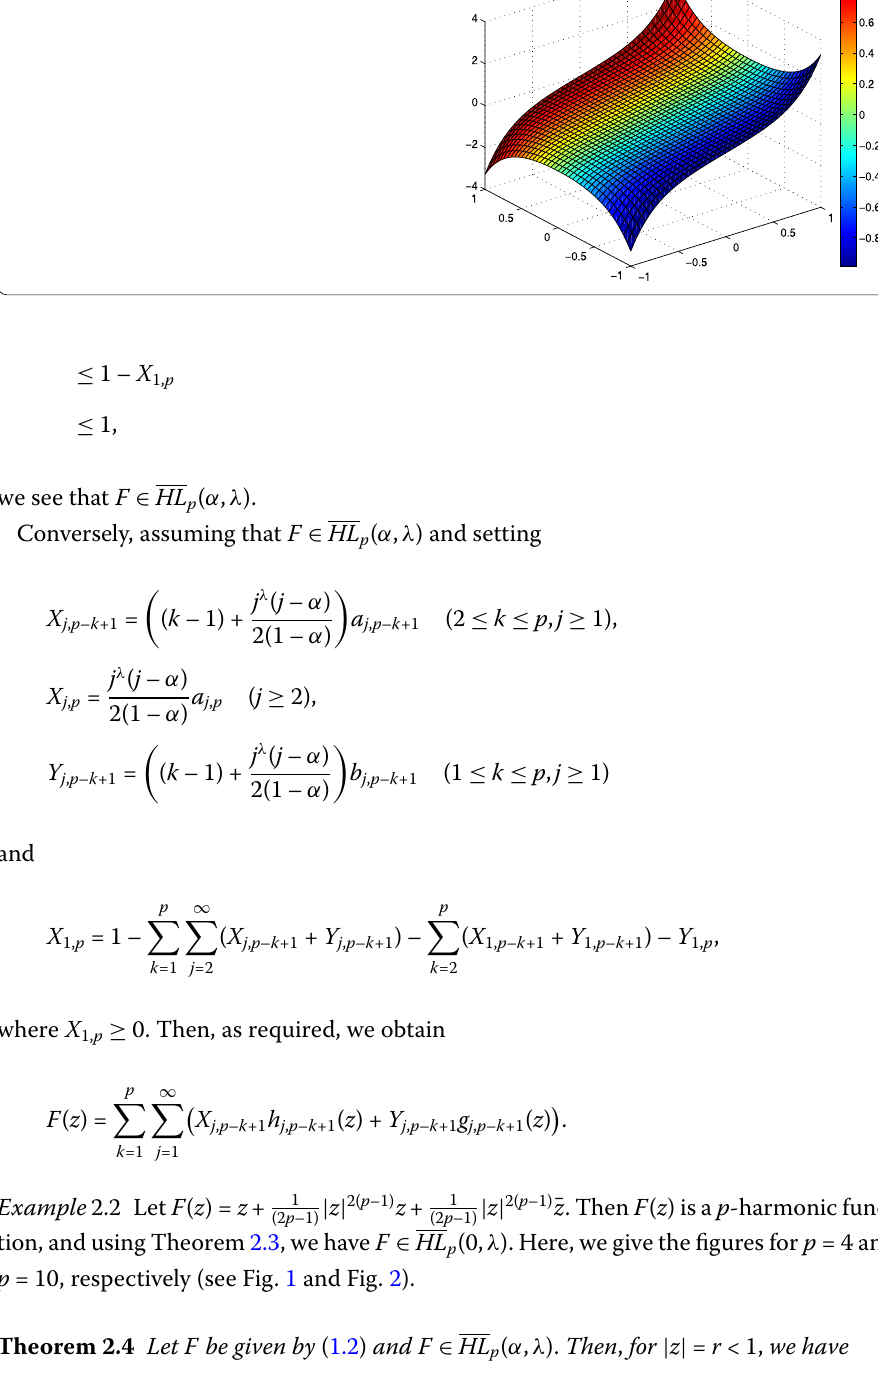
Figure 1 When F ( z ) is a 4-harmonic